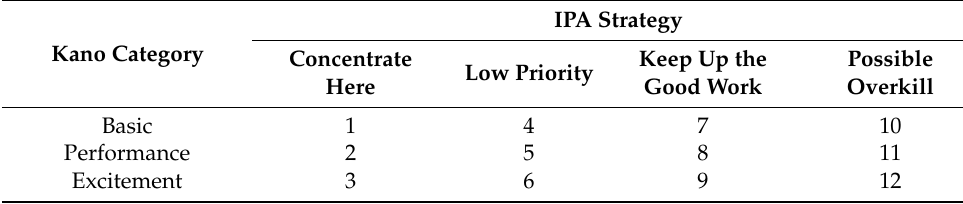
Table 3. The attribute priority rankings for resource allocation. Kano Category